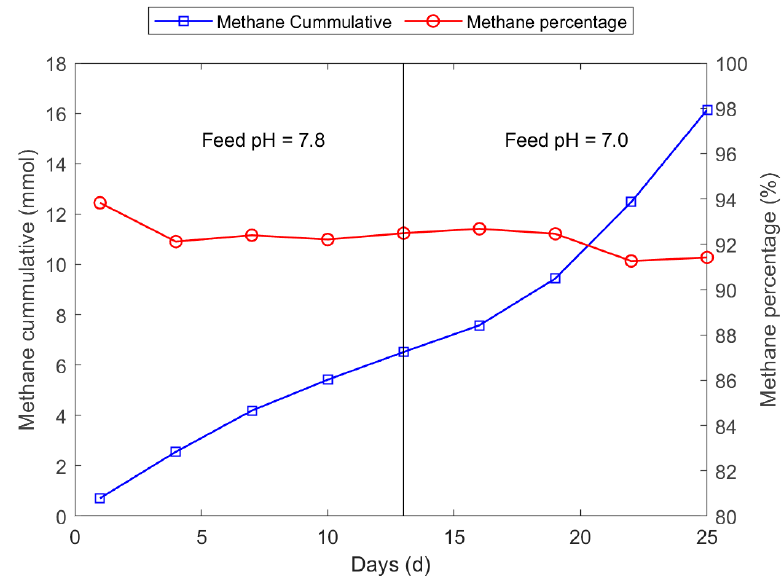
Figure 4. Cumulative methane production and methane percentage during optimisation of the pH experiment.